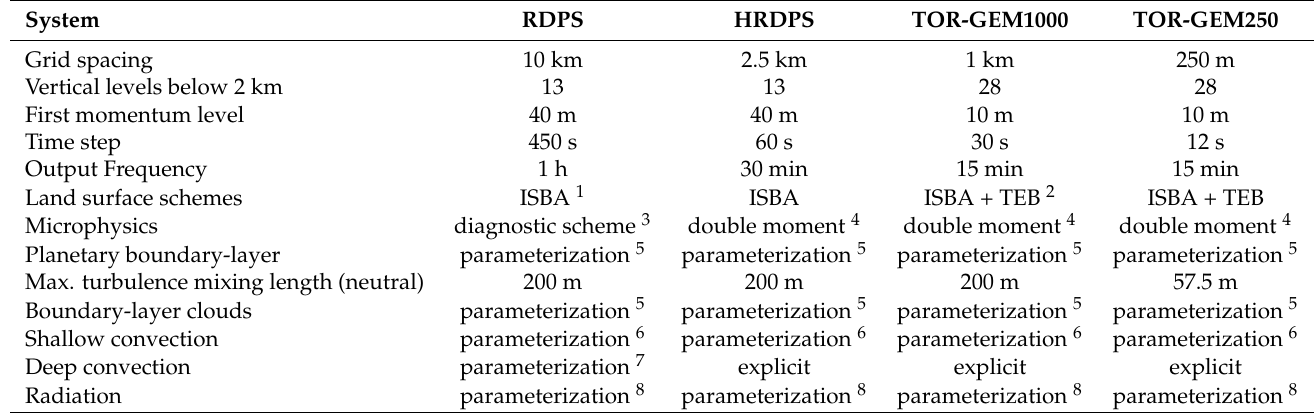
Figure 1. Geographical location of the forecast domains, ( a ) over the globe with limits of ECCC’s NWP systems with 10 km (RDPS) and 2.5 km (HRDPS) grid spacing, ( b ) focus for the two inner grids for TOR-GEM1000 and TOR-GEM250 for which TEB is activated over the gray shaded urban areas, and ( c ) orography (Above sea level elevation in m) and main landscape highlights represented in TOR-GEM250. Table 1. Summary of physical parametrizations in GEM used for the configurations